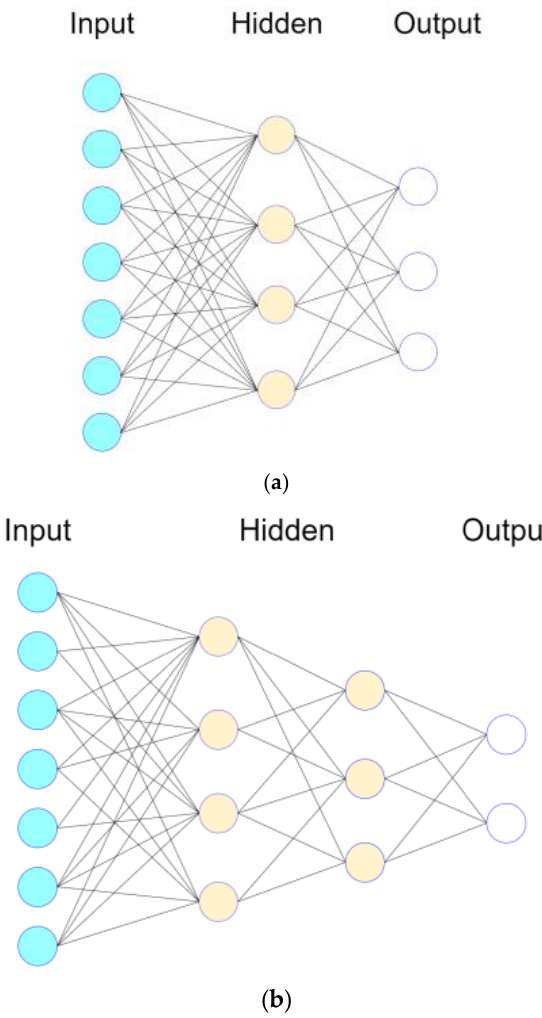
Figure 5. Representative ANNs, connectionisms, mimicking biologic NNs: ( a ) A connectionism is fully connected; ( b ) A connectionism considers dropout—one of the hyperparameters whose specified value is used to control the learning process of a connectionism—to prevent overfitting [28].